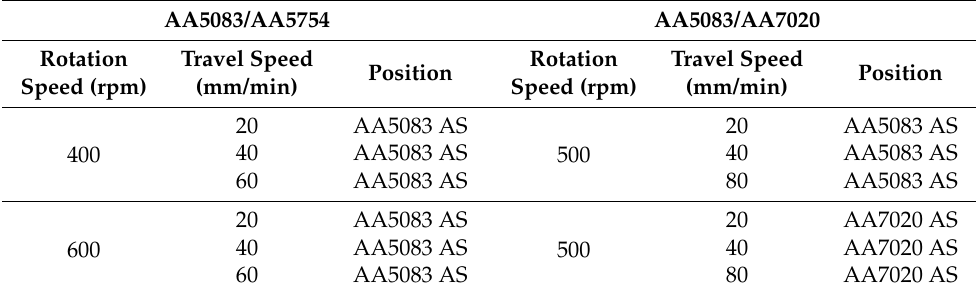
Figure 2. ( a ) The clamping of the plates on the FSW machine table with the advancing side (AS) and retreating side (RS) indicated and the tool rotation direction indicated also by the red arrow and ( b ) Aluminum alloys butt joint on the table after FSW. Table 3. FSW welding parameters and position of alloys at the AS and RS.